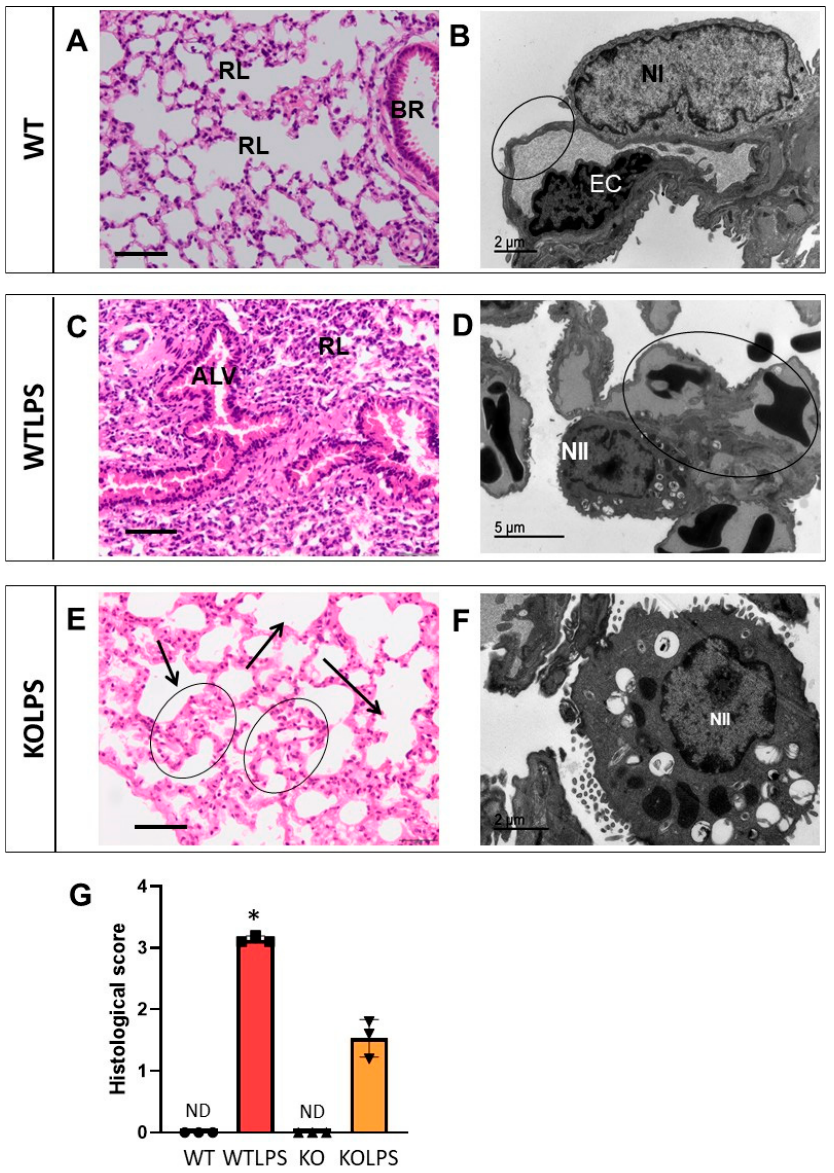
Figure 12. Histopathology of the lungs of mice from the different treatments assayed. ( A ) Lung in which an apparently normal bronchus (BR) and respiratory lobules (RL) stand out. ( B ) Detail of capillary and pulmonary alveolus separated by the respiratory barrier (circle) formed by the endothelial cell (EC) and pneumocyteI (NI). ( C ) Detail of lung that shows a marked atelectasis in both respiratory lobule (RL) and alveoli (ALV). ( D ) Detail of lung with capillary hyperemia (circle) and hypertrophy of pneumocytes II (NII). ( E ) Lung detail showing atelectasis zones (circle) and emphysema (arrow). ( F ) Septal hypertrophy of pneumocytes II (NII). ( G ) Histological score showing a semiquantitative analysis of atelectasis in the lung. The pathology scores were as follows: 0, without significant injuries (0%); 1, minimum (<10%); 2, mild (11–25%); 3, moderate (26–50%); 4, marked (51–75%); 5, severe (>75%). Histopathological evaluation is performed in a blind manner by two highly experienced pathologists. Results are mean ± SD of N = 3 animals. Statistical significance (two tailed Student- t test), * p < 0.001. Abbreviations: WT, wild type mice; WTLPS, wild type mice treated with LPS; KO, Gal3 knockout mice; KOLPS, Gal3 knockout mice treated with LPS; ND, not damaged. ( A , C , E ), optical microscopy. Scale bars: 100 µ m. ( B , D , F ), ultrastructural observations. Scale bars: ( B , F ), 2 µ m; ( D ), 5 µ